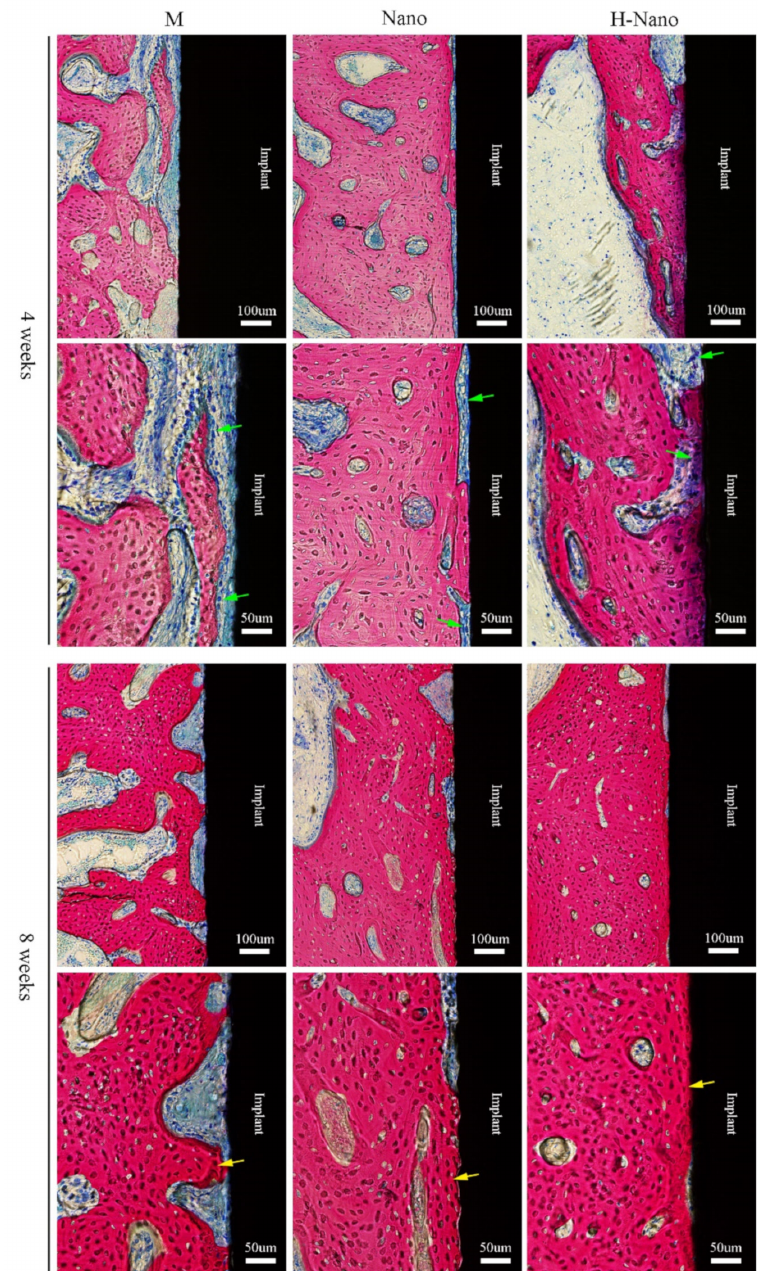
Figure 5. Histological observation of the M, Nano, and H-Nano group after 4 and 8 weeks. Each set of images for all groups were illustrated from three different magnifications of the same region. Methylene blue and acid fuchsin staining. Green arrows: osteoblasts (dark blue). Yellow arrows: new bone formation (dark